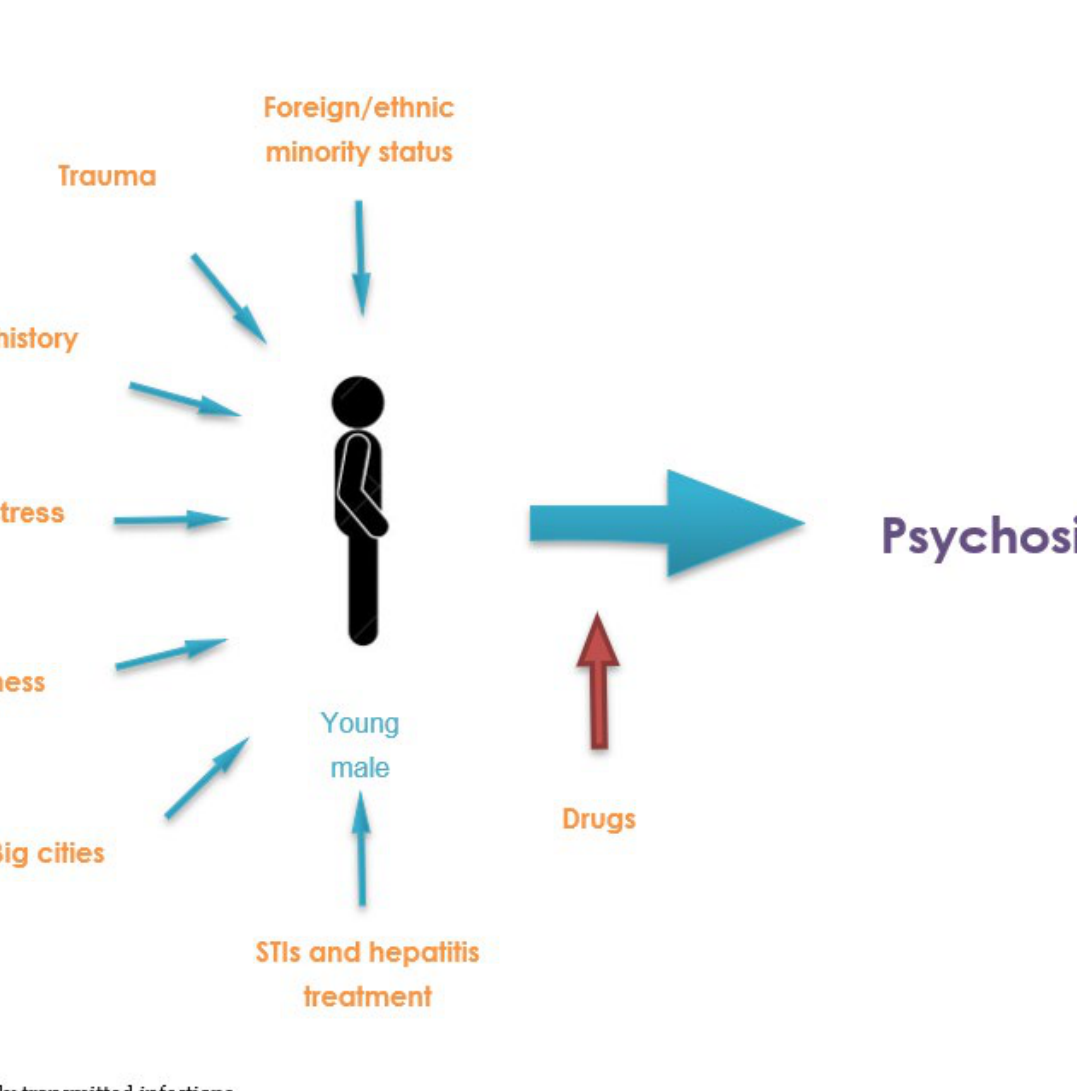
Figure 2. Diagram of the relationship between chemsex and psychosis.